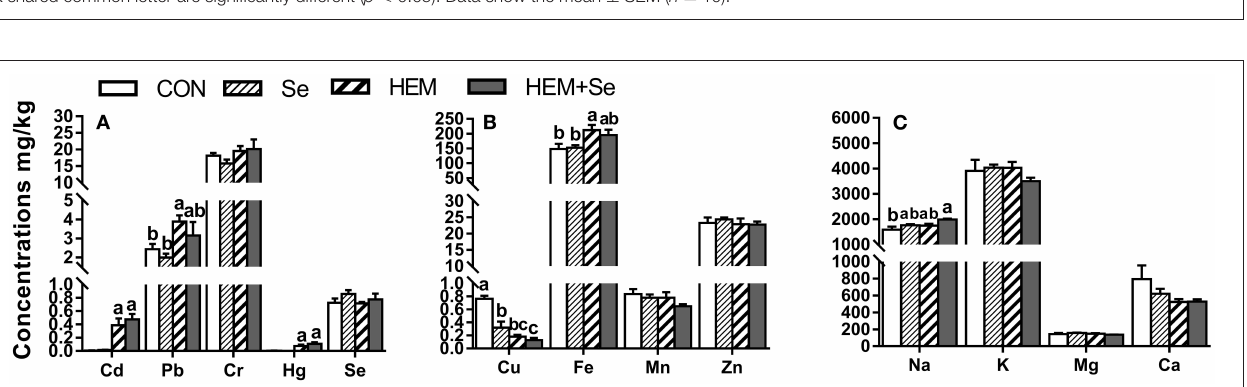
Cu, Zn, and Ca in the follicular walls compared to the HEM- treated group. Dietary treatments also did not significantly affect the concentrations of Pb, Cr, Fe, Mn, Na, and K in the follicular walls ( p >